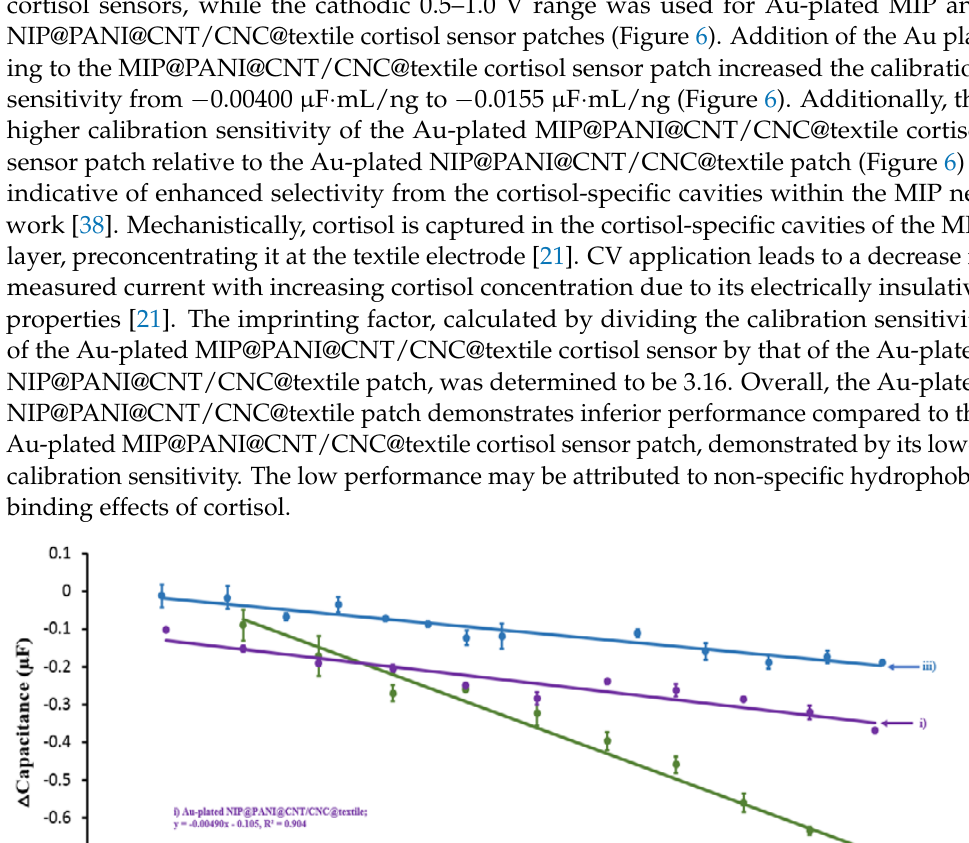
Table 2. Literature comparison of cortisol sensor performance metrics to the reported Au-plated